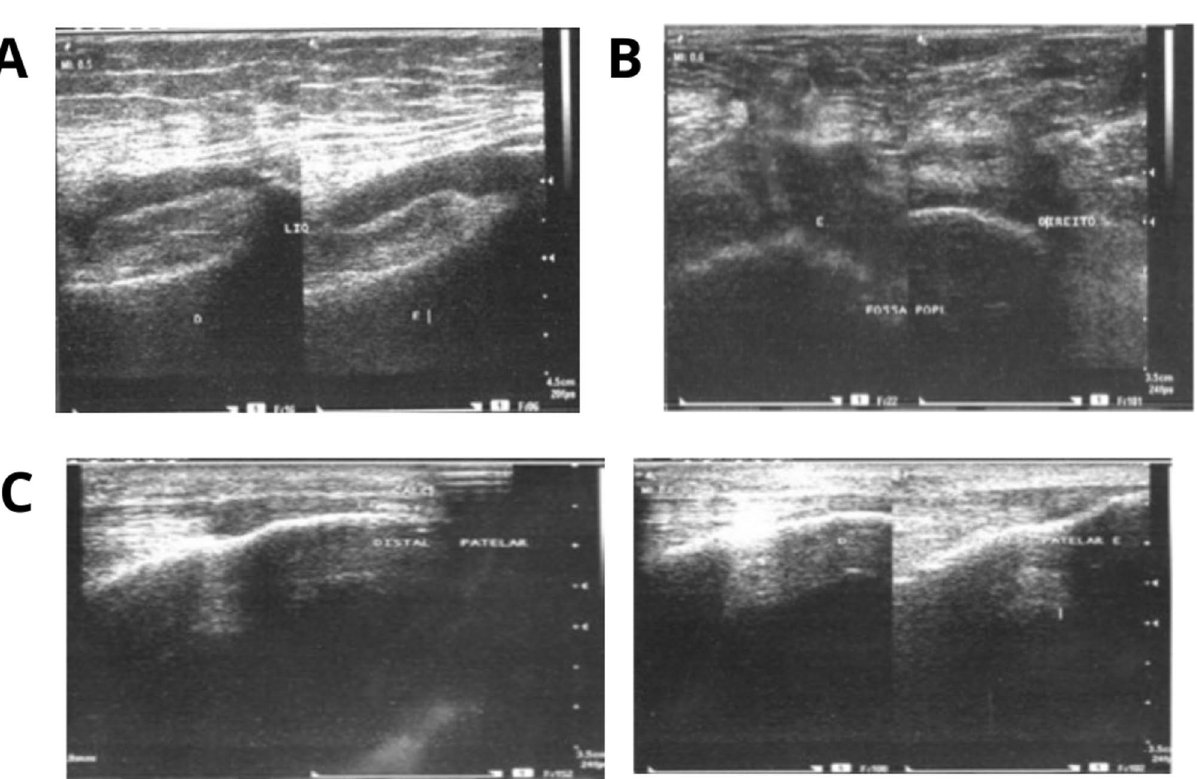
Figure 2. Knee ultrasonography. ( A ) Joint effusion. ( B ) Popliteal cyst. ( C ) Patellar